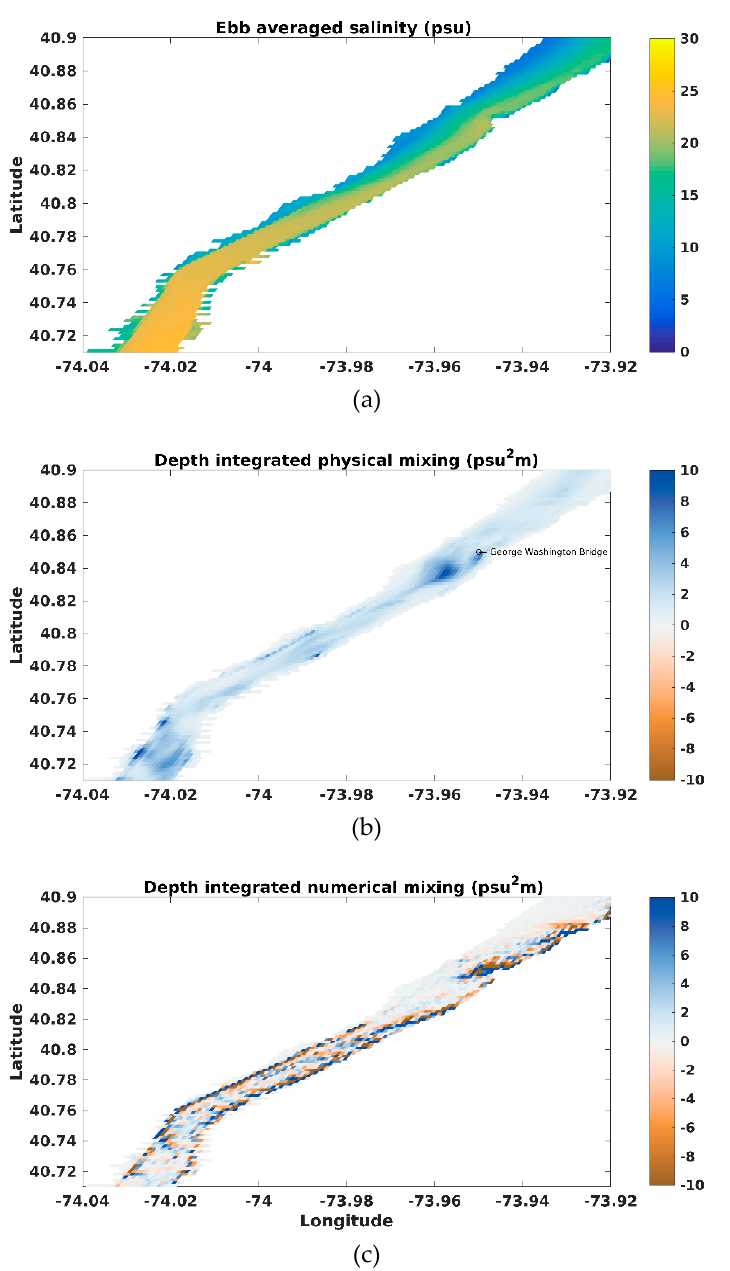
Figure 9. Hudson River estuary: ( a ) Salinity distribution, and depth integrated ( b ) physical and ( c ) numerical mixing during time averaged ebb cycle.